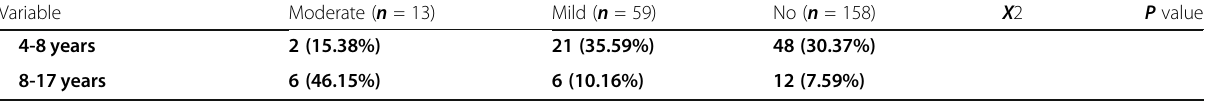
No severity risk for suicidality has been